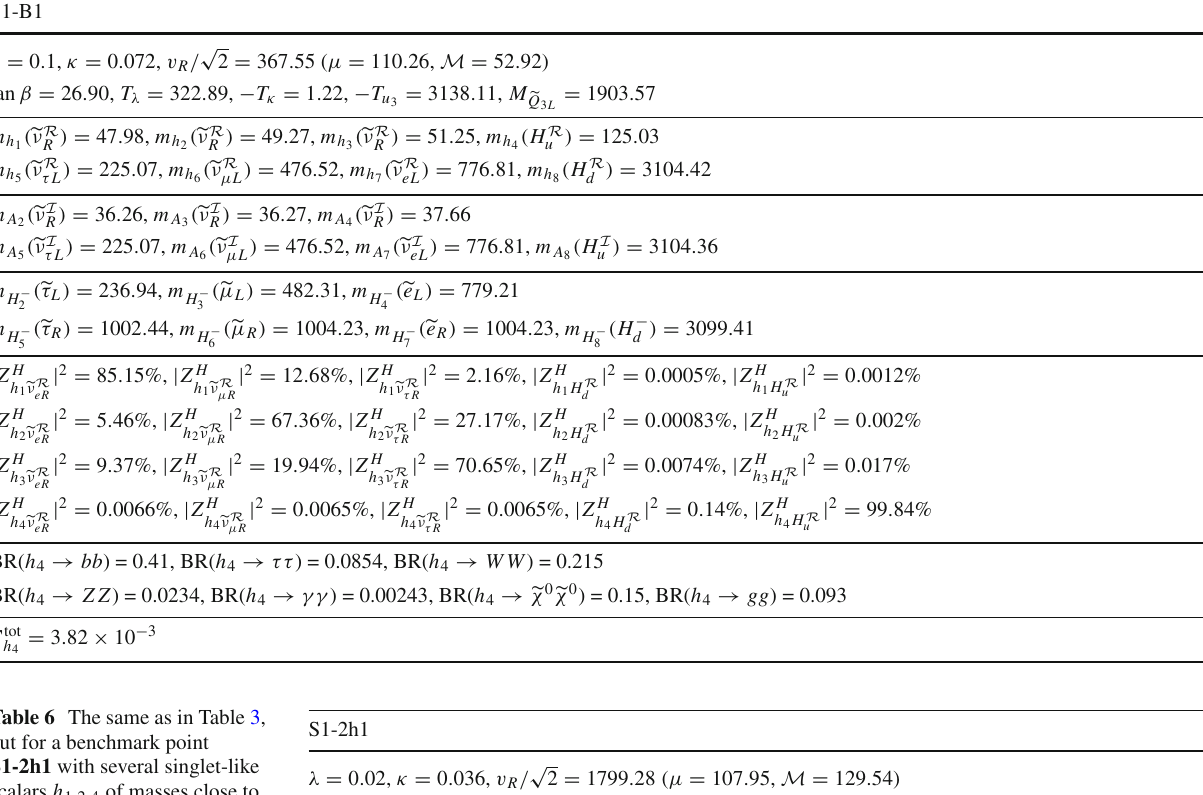
Table 6 The same as in Table 3, but for a benchmark point S1-2h1 with several singlet-like scalars h 1 , 2 , 4 of masses close to the mass of the SM-like Higgs h 3 . Their branching ratios are shown in the sixth–nineth boxes, and their decay widths in the tenth